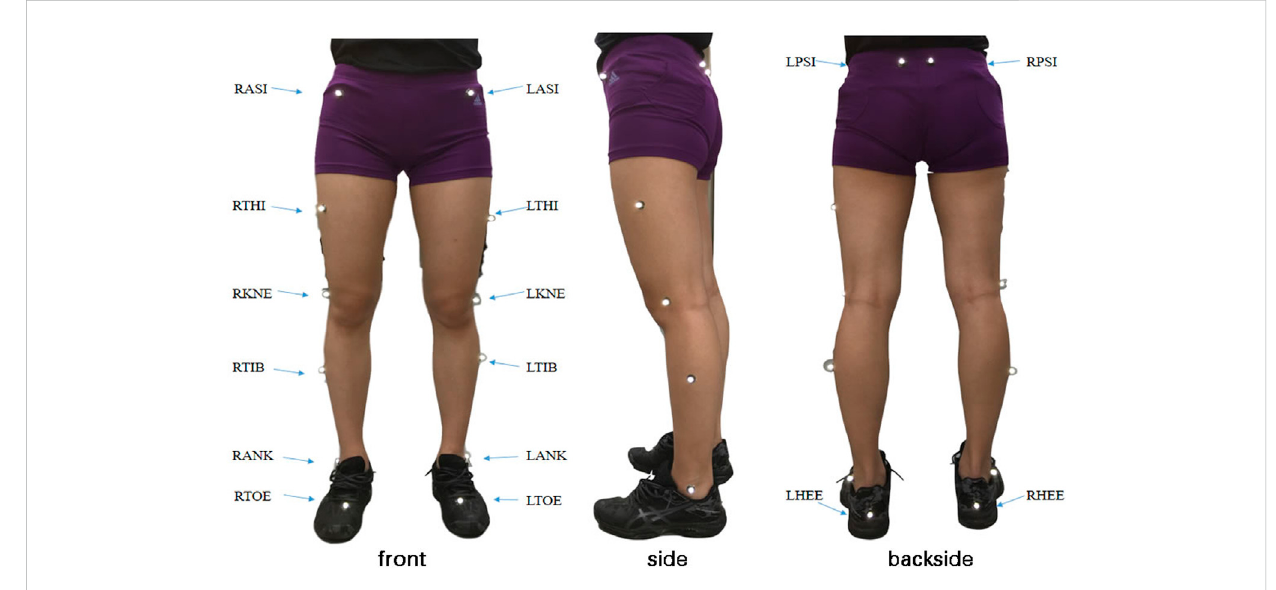
Lower-limb anatomy location in participants.